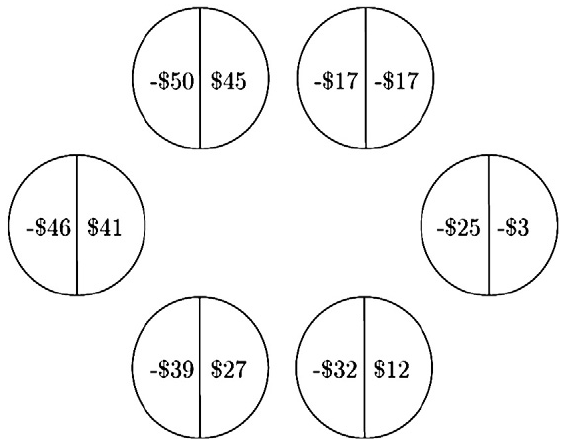
Figure A3. Lottery choices in the loss game. The game is based on [46]. Value are in 2014 BRL. This game intends to capture baseline attitudes towards risk. Subjects choose one of six lotteries. As one moves clock-wise around the ring, the lotteries increase in risk and expected payoff except for the last lottery, which has the same expected payoff as the fifth but is riskier. Within each lottery, the odds of a high payment are the same as the odds of a low payment (50% probability). To determine payouts for the task, participants choose one lottery to play. A computer then randomly draws an outcome. This game is essentially equal to the risk game with $50 being subtracted to the payoffs. Participants are given an endowment of $50 to ensure that no one will lose money by participating in this